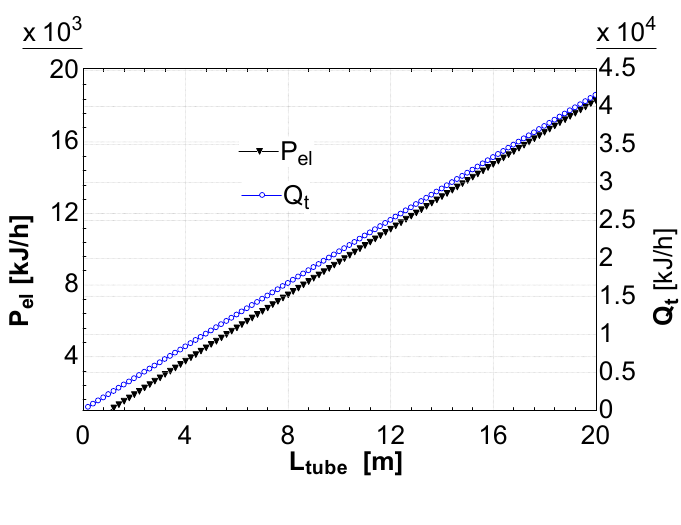
Figure 6. CPVT Temperatures vs. L